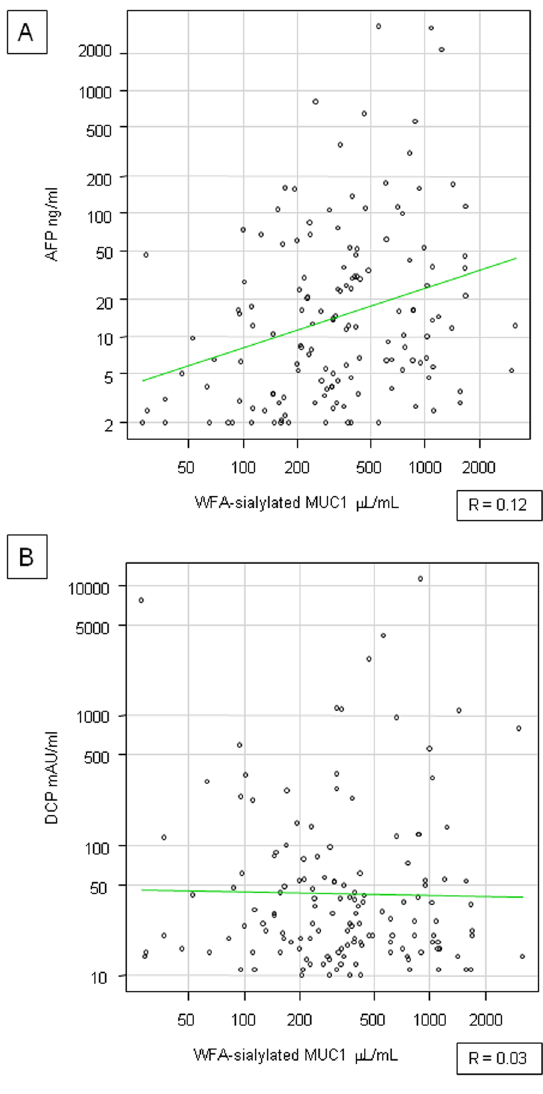
Figure 4. Correlation between serum WFA-sialylated MUC1 and other serum tumor markers. ( A ) Serum WFA-sialylated MUC1 and AFP ( B ) Serum WFA-sialylated MUC1 and